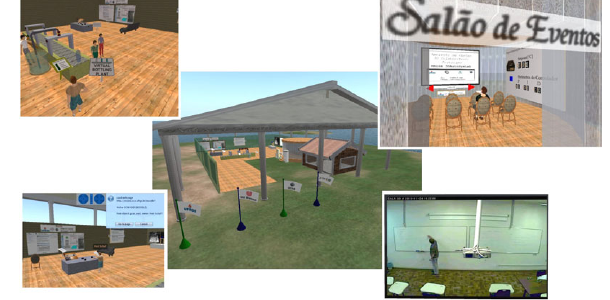
Figure 2. 3D AutoSysLab metaverse client interface